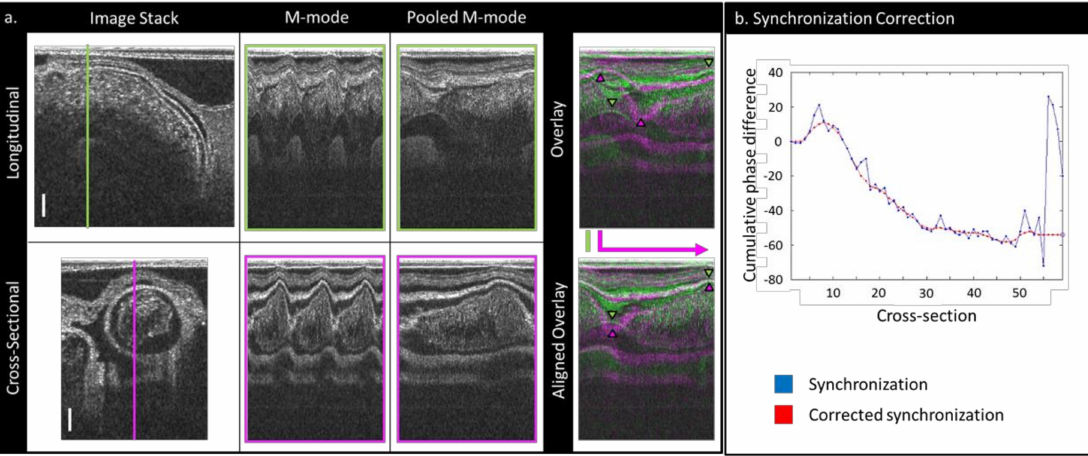
Figure 2. An illustration of the synchronization method employed to reconstruct 4-D OFT images from non-gated OCT datasets: ( a ) a schematic showing how m-modes are used to pool cardiac cycle information and to align cross-sectional datasets with the longitudinal dataset. Scale bars: 150 µ m. ( b ) A plot showing an example of how the initial synchronization can be corrected and smoothed by the user: The phase scale is in units of pooled frames (1/200th of a cardiac